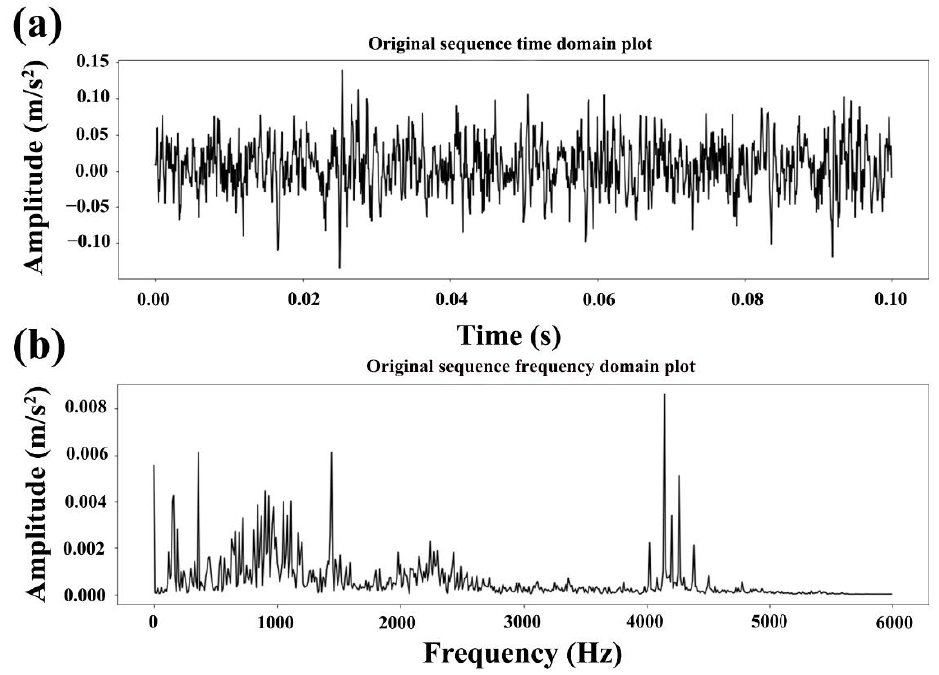
Figure 7. ( a ) Original sequence time-domain plot ; ( b ) frequency-domain plot.